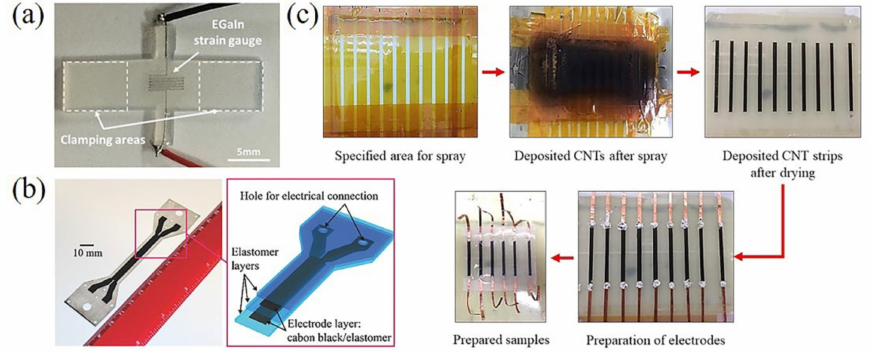
Figure 1. ( a ) An EGaIn strain sensor, ( b ) a carbon black/elastomer composite flexible sensor, and ( c ) the fabrication process of a mask-sprayed flexible